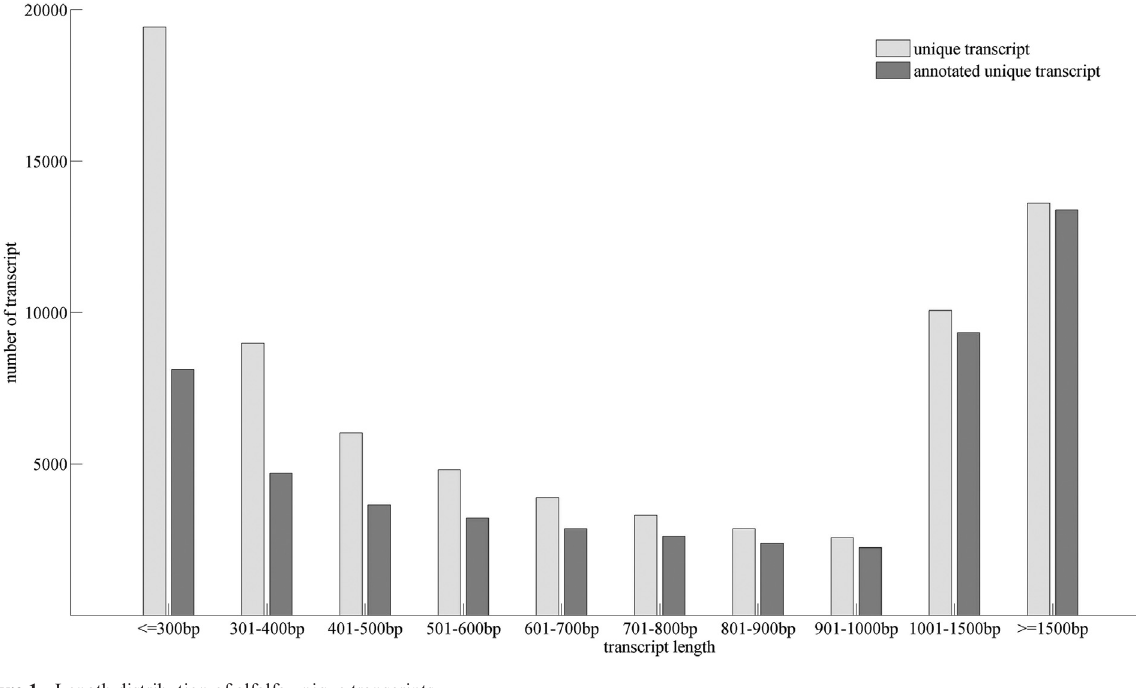
Figure 1 - Length distribution of alfalfa unique transcripts.